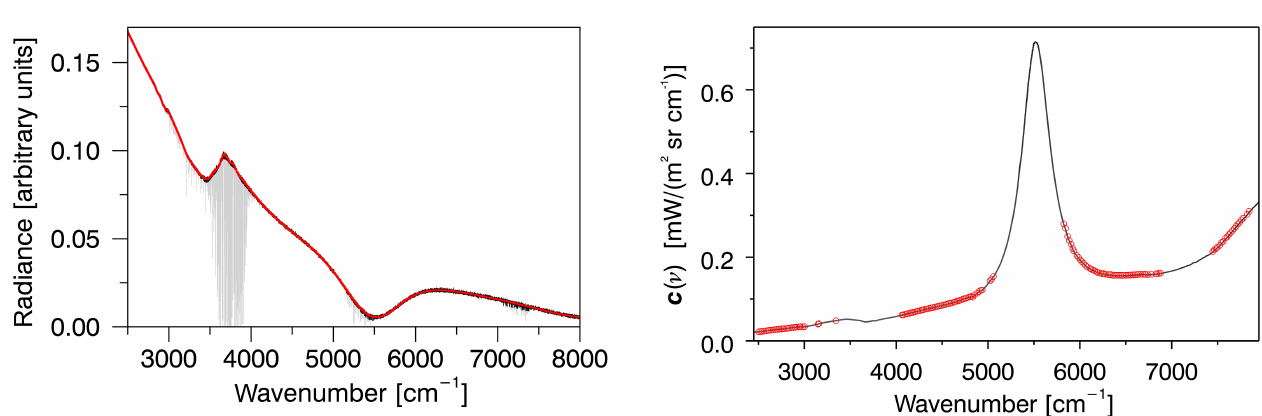
Figure 5. Combined calibration curve (black line) and selected Lan- gley calibration points (red circles) for the Langley measurements made on 13 December 2013 in combination with blackbody mea- surements made on 24 February